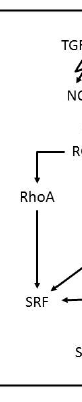
Figure 4. Illustration of neutrophil NOX ‐ HOCl production. Neutrophils have phagosomes and